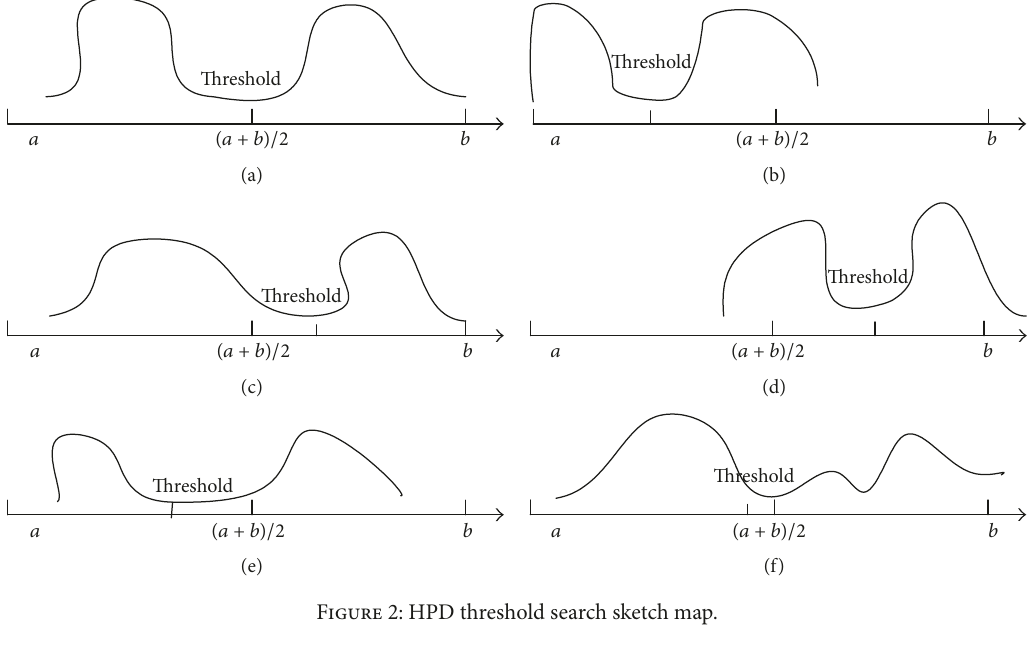
Figure 2: HPD threshold search sketch map.